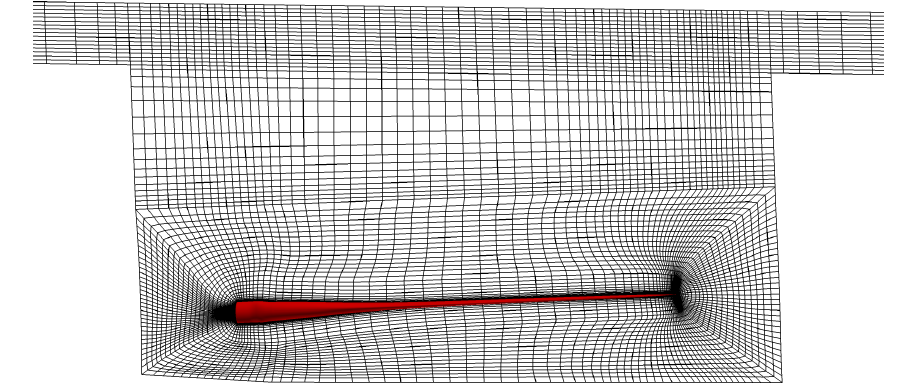
Figure 6. Volume mesh for the confined setup (shown as the computational surface at the midpoint). Only every second line is shown for visual